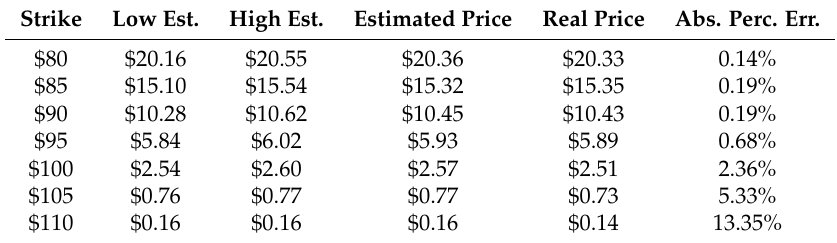
Table 1. Comparison of the estimated and ’real’ American option prices with different strikes. Absolute percentage errors are also included.